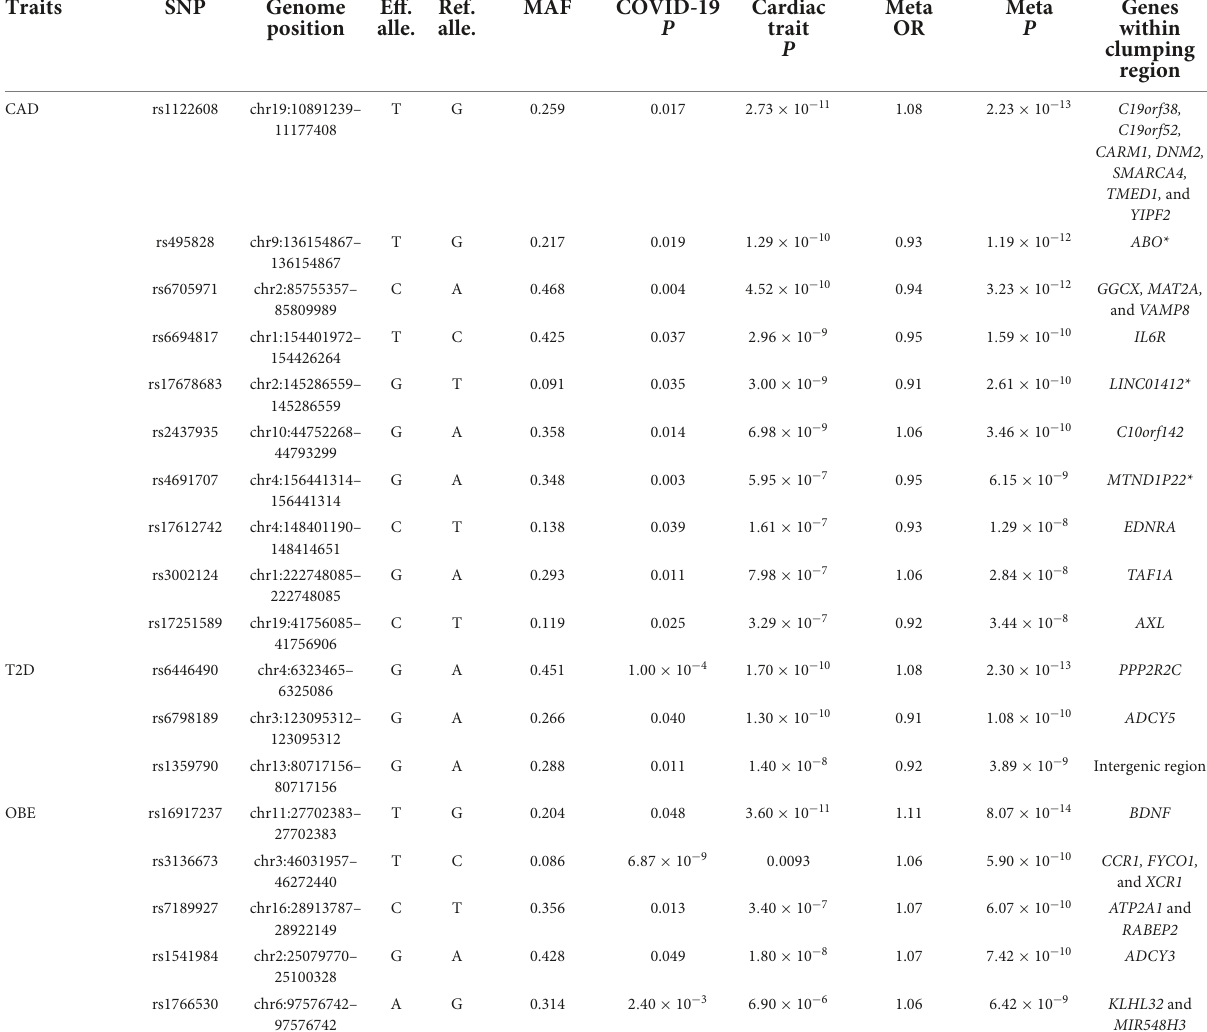
Eff. Ref. MAF COVID-19 position alle. alle.